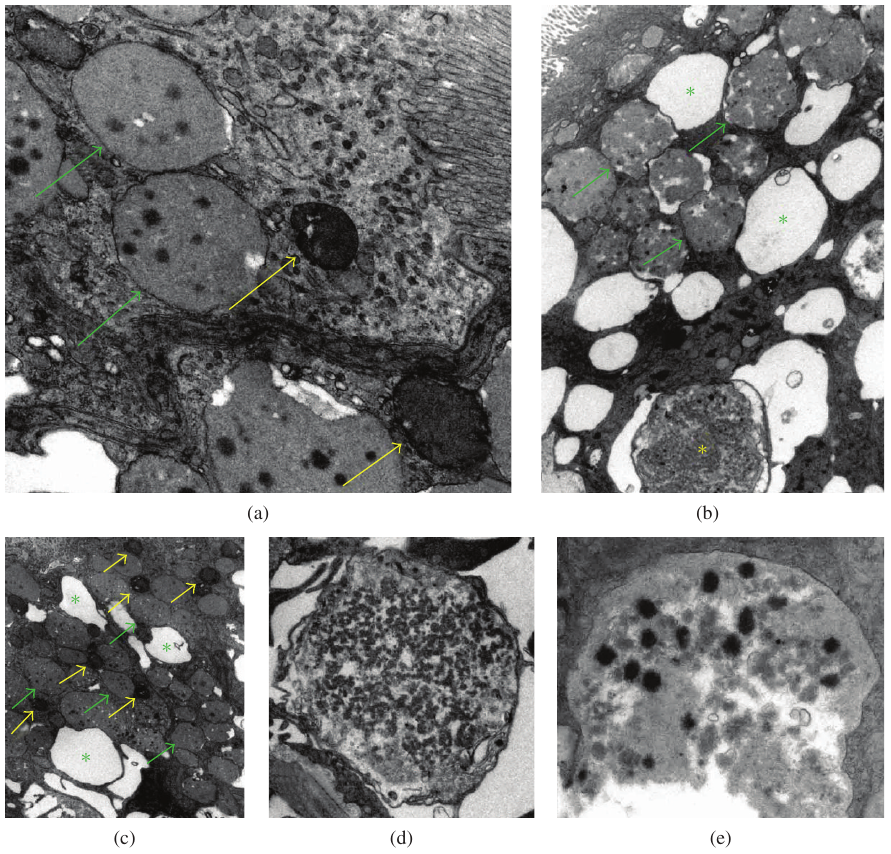
FIGURE 6: Ultrastructural changes in the hepatopancreas of B. aeruginosa exposed to the suspension of M. aeruginosa and mixed algae, respectively. (a) The proliferation of lysosomes (yellow arrow) and heterolysosomes (green arrow) in the mixed group at 5 days postexposure, 40000x. (b) The vacuoles (green star), telolysosomes (yellow star), and heterolysosomes (green arrow) in the cyanobacterial group at 10 days postexposure, 18000x. (c) A large amount of lysosomes (yellow arrow), heterolysosomes (green arrow), and the vacuoles (green star) in the cyanobacterial group during the depuration, 8000x. (d) and (e) The telolysosome in the mixed and cyanobacterial group during the depuration, respectively,